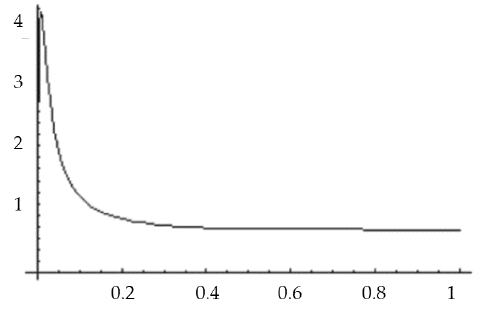
Figure 4. Levy’s adapted function model profile graph [1 8].